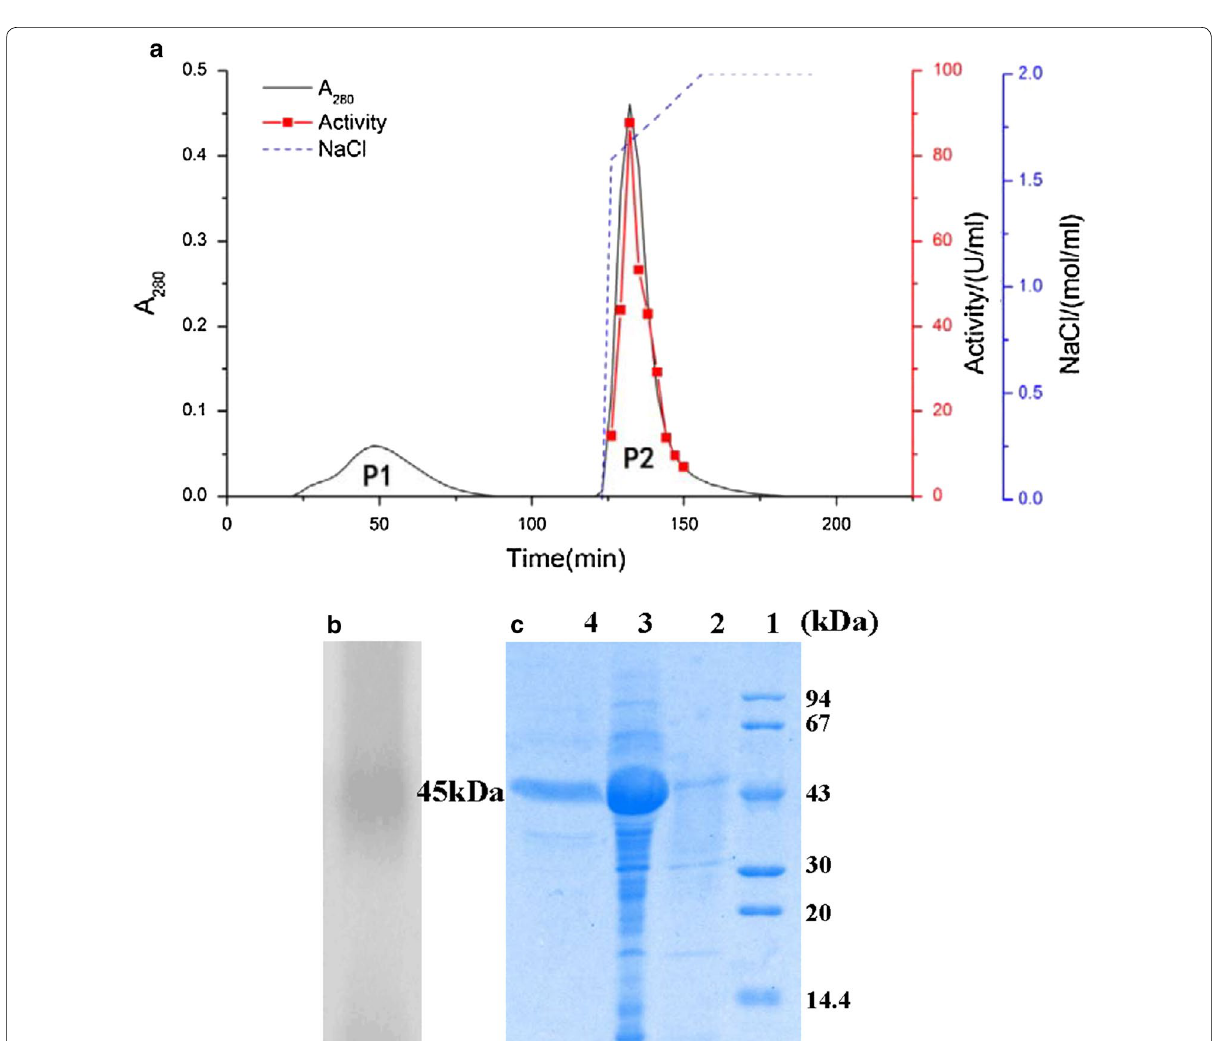
Fig. 2 a Ion exchange chromatography of DEAE‑Sepharose FF (30 crude and purified protease from Aspergillus oryzae Y1. Lane 1 low molecular weight; lane 2 crude extract; lane 3 ammonium sulfate precipitation; lane 4 purified neutral